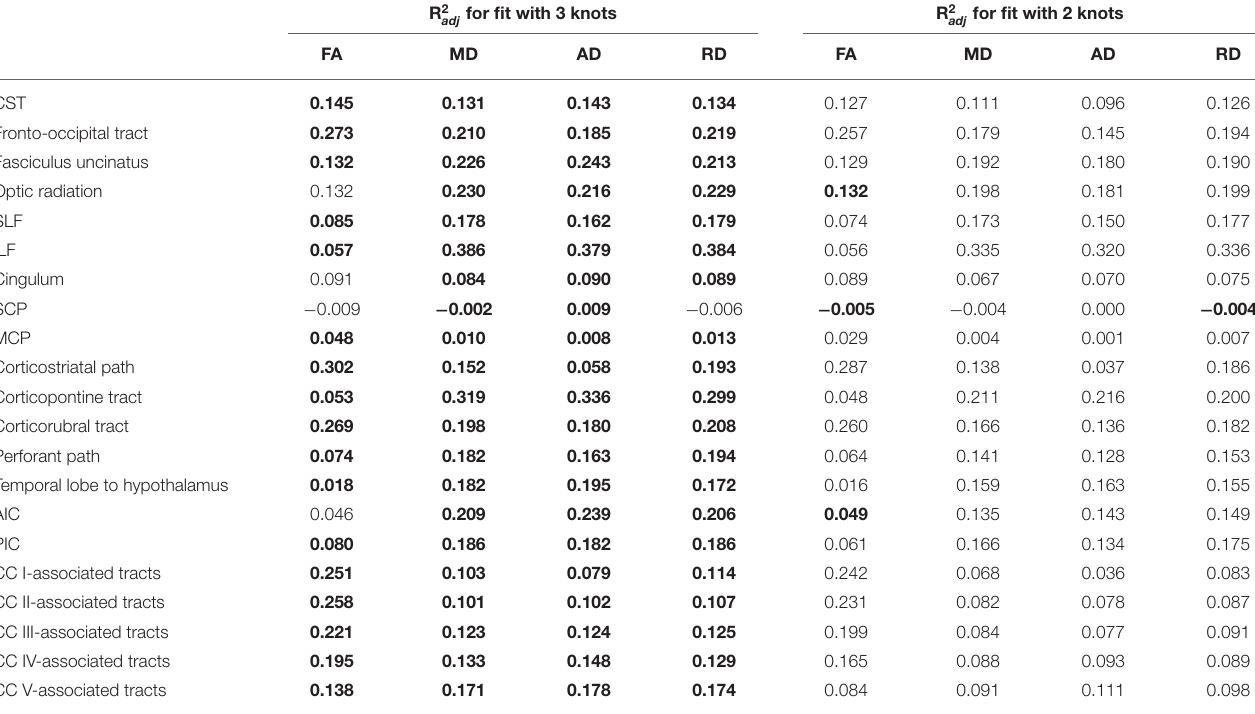
TABLE 2 | Adjusted coefficients of determination R 2 adj of shape prescriptive fits of fractional anisotropy (FA), mean diffusivity (MD), axial diffusivity (AD), and radial diffusivity (RD) over adulthood with two and three knots. R 2 adj for fit with 3